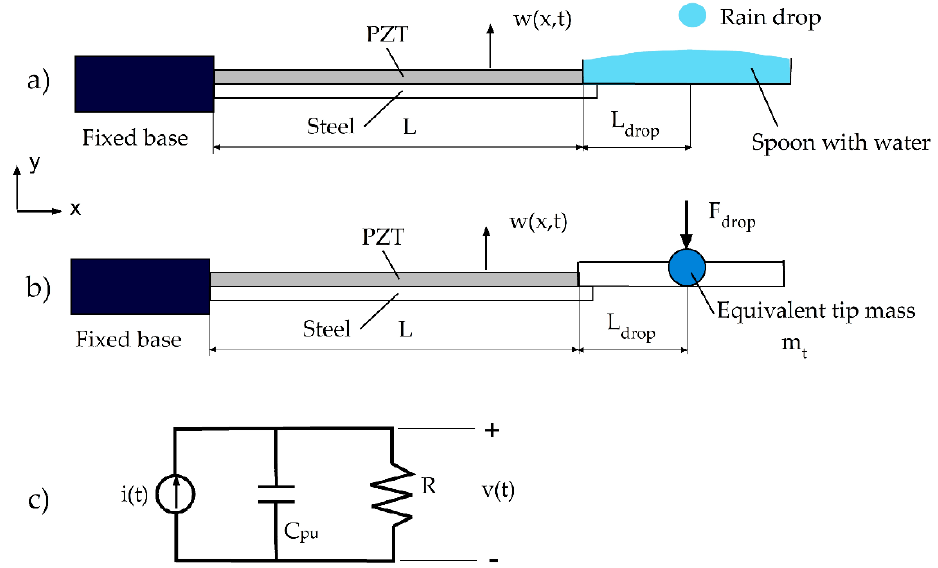
Figure 3. Mathematical model of the harvester with spoon; ( a ) full mechanical model with spoon; ( b ) equivalent mechanical model; ( c ) equivalent electric circuit.